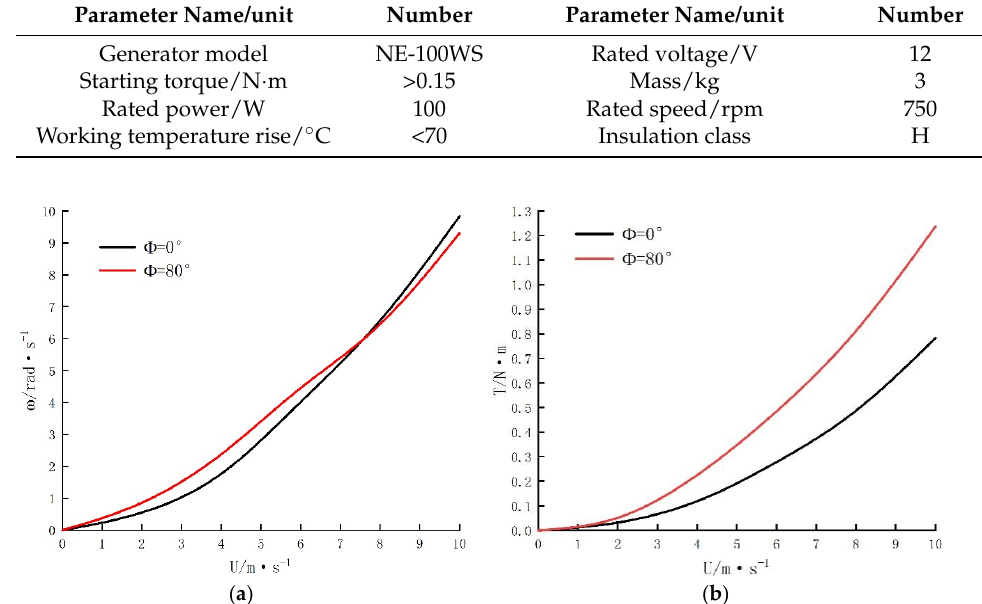
Figure 8. Parametric curves of two morphological leaves: ( a ) rotation rate, ( b ) self ‐ starting torque.